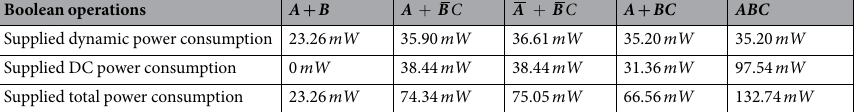
Table 2. Supplied power consumption for different Boolean operations.